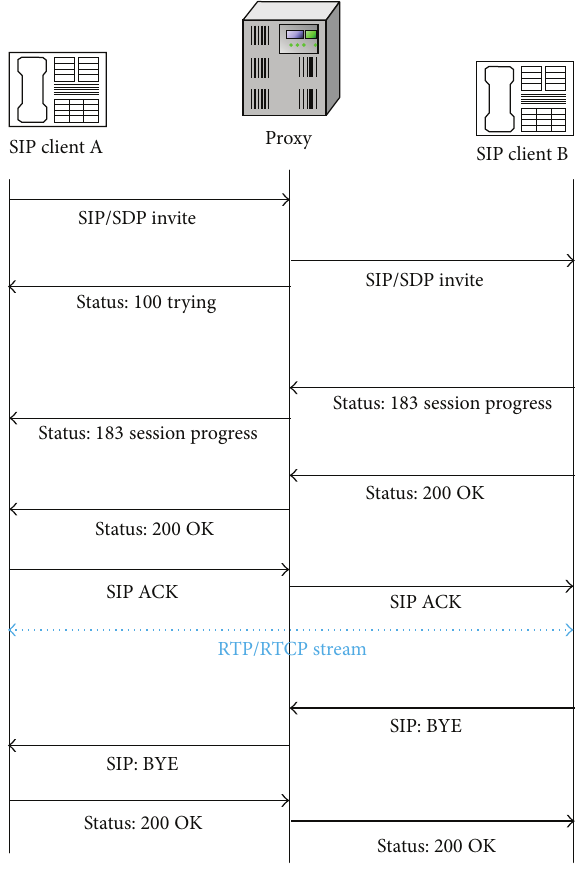
Figure 1: Call management by